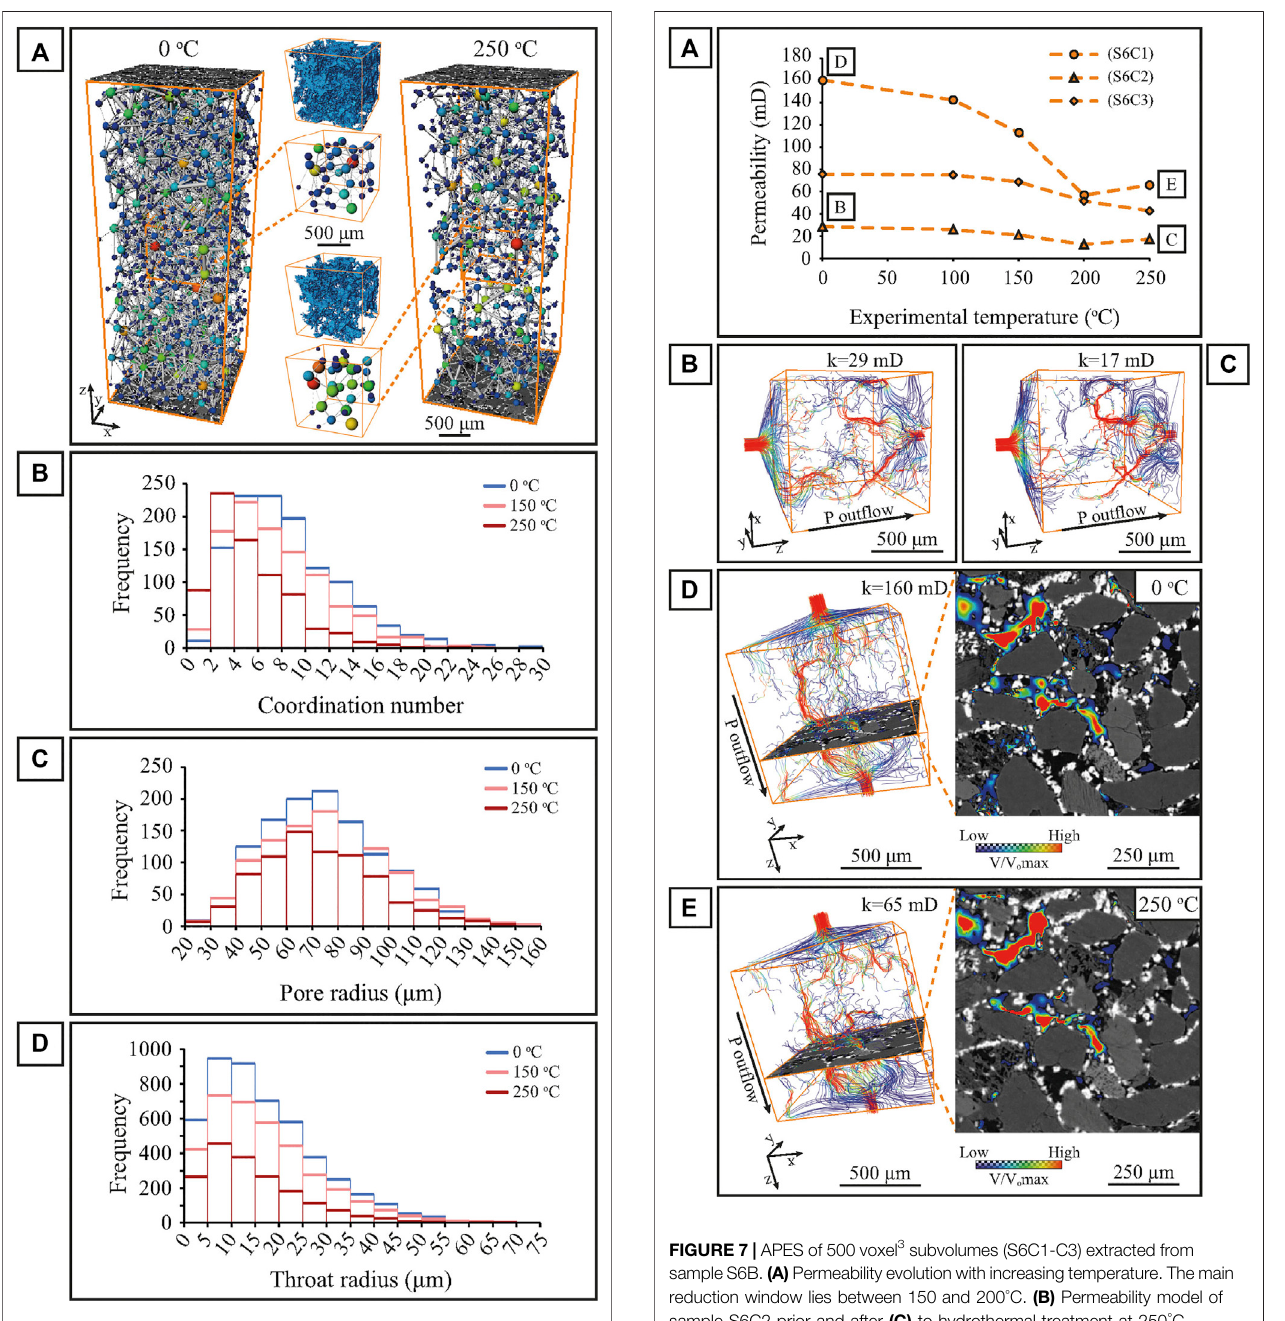
FIGURE 6 | Comparison between the PNM data of the initial (0 ° C), middle (150 ° C) and fi nal (250 ° C) experimental stage of sample S6B. (A) 3D visualizationofpore networkmodel ofthewholesample(S6B)and azoomed- in cubic subset (S6C2) with the equivalent 3D volume rendering of the connected porosity. Pore and throat size of the porosity models indicates the inscribed radius and length, respectively. Larger pores are shown in red and smaller pores are shown in blue. Frequency distribution plot of the coordination number of pores (B) , pore radius (C) and, the throat radius (D) per experimental temperature. Colors indicating temperature and volume resolution are as on previous fi gures.